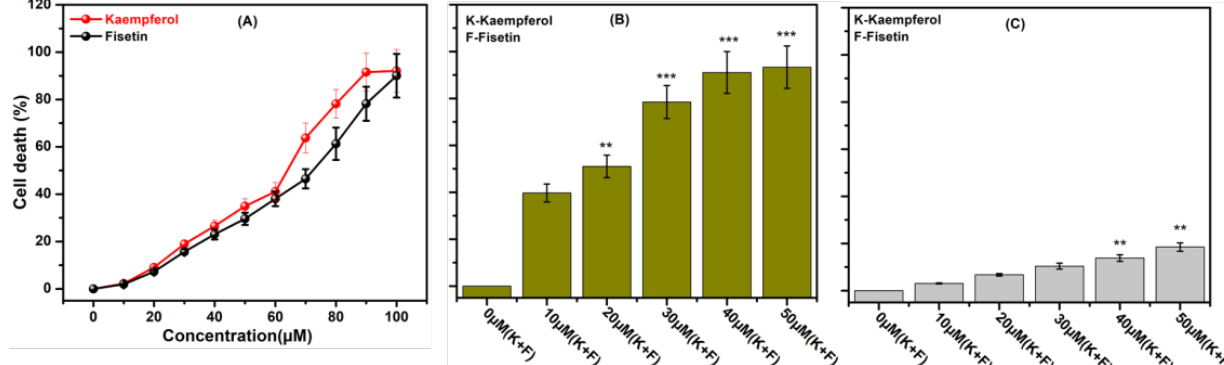
Figure 2. MTT assay showing ( A ) the effect of increasing doses (0–100 µ M) of kaempferol (K) and fisetin (F) on the MDA-MB-231 cell line after 24 h, ( B ) the effect of K and F combination treatment on the MDA-MB-231 cell line after 24 h, and ( C ) the effect of K and F combination treatment on the MCF-10A cell line after 24 h. The significant results with p values < 0.05 are labelled as follows ( B ): ** control versus 20 µ M (K) + 20 µ M (F); *** control versus 30 (K + F), 40 (K + F), and 50 µ M (K + F). Statistical significance: ** p < 0.01, and *** p < 0.001.